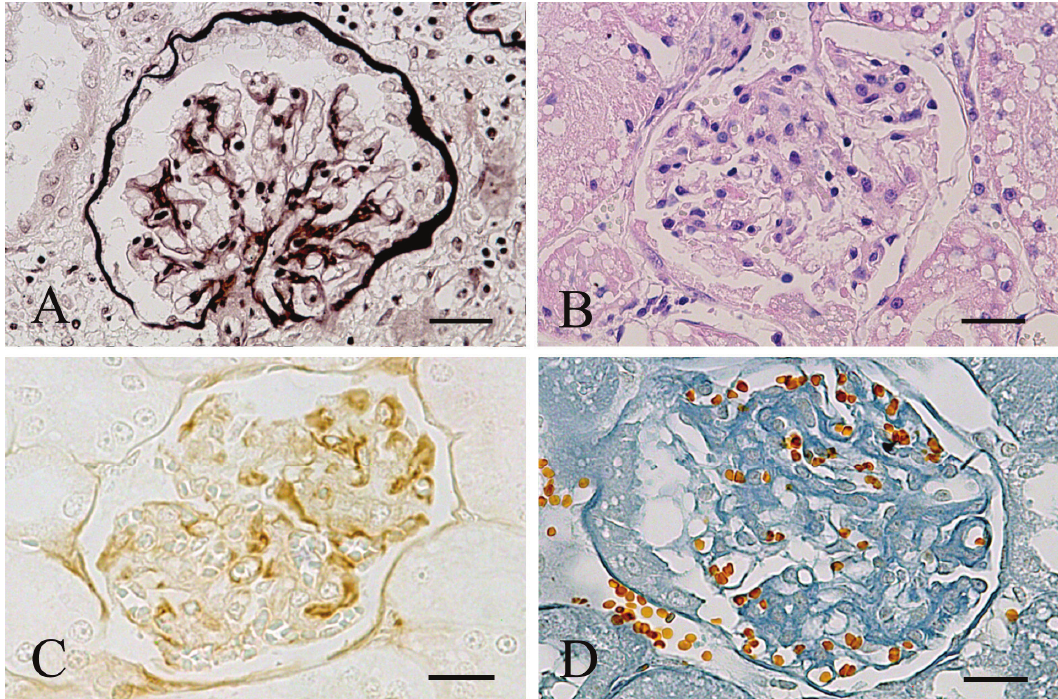
Figure 2. Representative results of renal lesions observed in FIV-M2-infected cats. ( A ) Mesangial widening. Mild increase in mesangial matrix with a minimal increase in intraglomerula cellularity. Jones’ periodic acid-silver methenamine stain. (Bar = 80 µm); ( B ) Segmental mesangioproliferative glomerulonephritis. Scattered areas of mild proliferation of mesangial cells with scanty inflammatory infiltrates. Hematoxylin-Eosin stain. (Bar = 80 µm); ( C ) Mesangioproliferative glomerulonephritis. Segmental deposition of IgG. Strepavidin biotin peroxidise complex method, Mayer’s hematoxylin counterstain. (Bar = 80 µm); ( D ) Membranoproliferative glomerulonephritis. Mesangial enlargement and thickening of capillary walls with tram track appearance. Azan trichromic stain. (Bar = 80